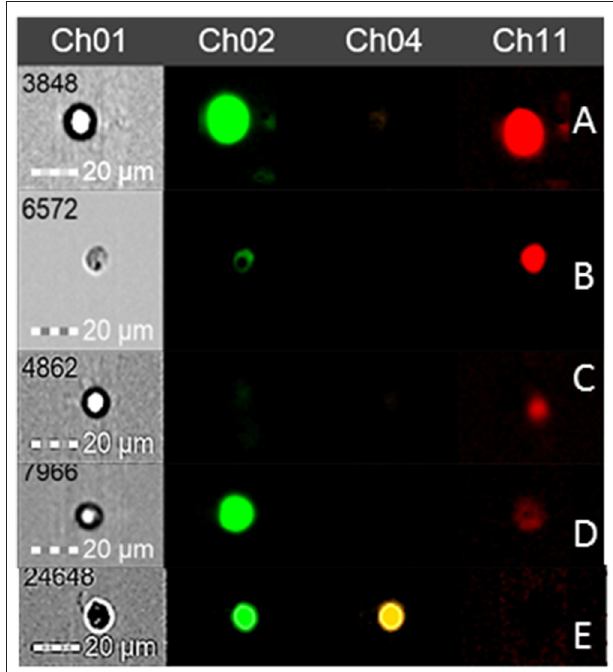
FIGURE 1 | Round spermatogonial cells observed by flow cytometry with DBA (Channel 2), 7AAD (Channel 4), and MitoSense (Channel 11) fluorochromes. (A) SSC (sDBA + ) with intact mitochondrial membrane (sMitoSense + ). (B) Early differentiating SSC (wDBA + ) with intact mitochondrial membrane (sMitoSense + ). (C) Differentiated round spermatogonial cell (DBA-) in early apoptosis (wMitoSense + ). (D) SSC (sDBA + ) in early apoptosis (wMitoSense + ). (E) Necrotic SSC (7AAD +